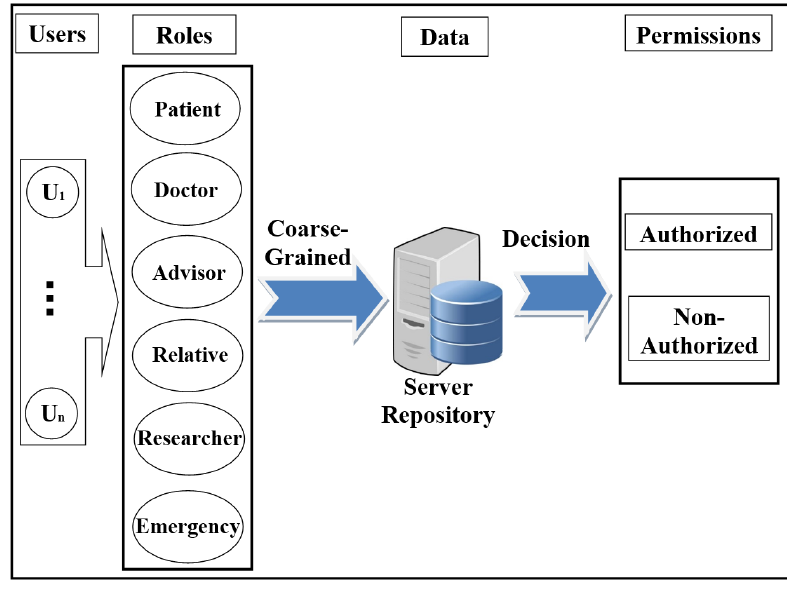
Figure 1. Scheme of role-based access control (RBAC) model.